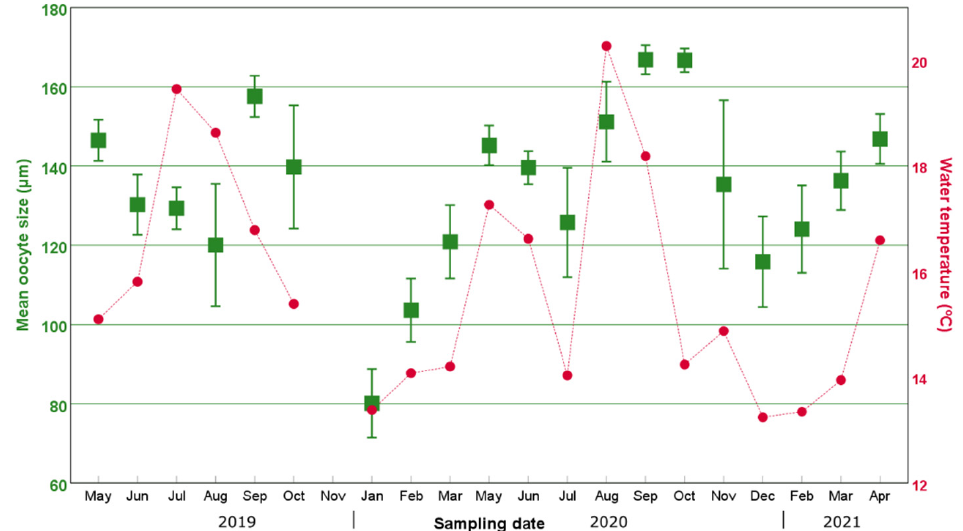
Figure 5. Temporal variation in the mean oocyte size (squares) over the 2-year period studied in this